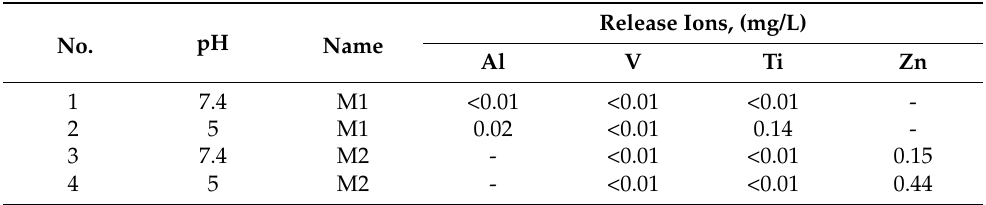
Table 5. Results of inductively coupled plasma atomic emission spectrometry (ICP–AES) analysis.